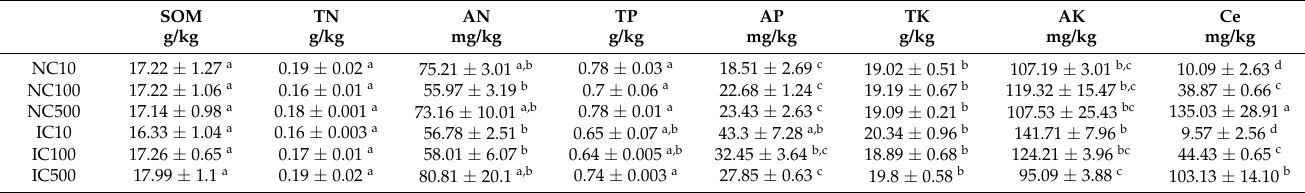
Table 1. Soil physicochemical properties in different